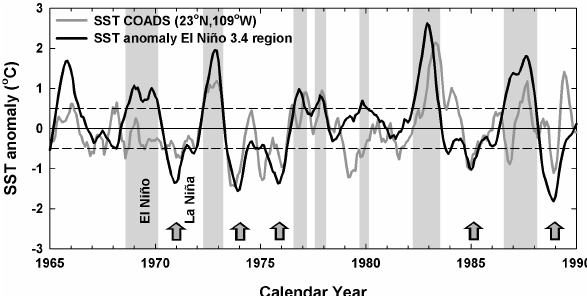
Fig. 2. Comparison of temperature anomalies in the Ni˜no 3.4 re- gion, filtered by a 5-month moving average that define the variabil- ity of El Ni˜no (Trenberth, 1997) versus the temperature anomalies (same filtering) in the mouth of the Gulf of California obtained from the COADS database (resolution of 2 ◦ × 2 ◦ , Slutz et al., 1985). The gray bars define the timing and duration (months) of the El Ni˜no events and the arrows indicate the cold events of La Ni˜na defined by Trentberth